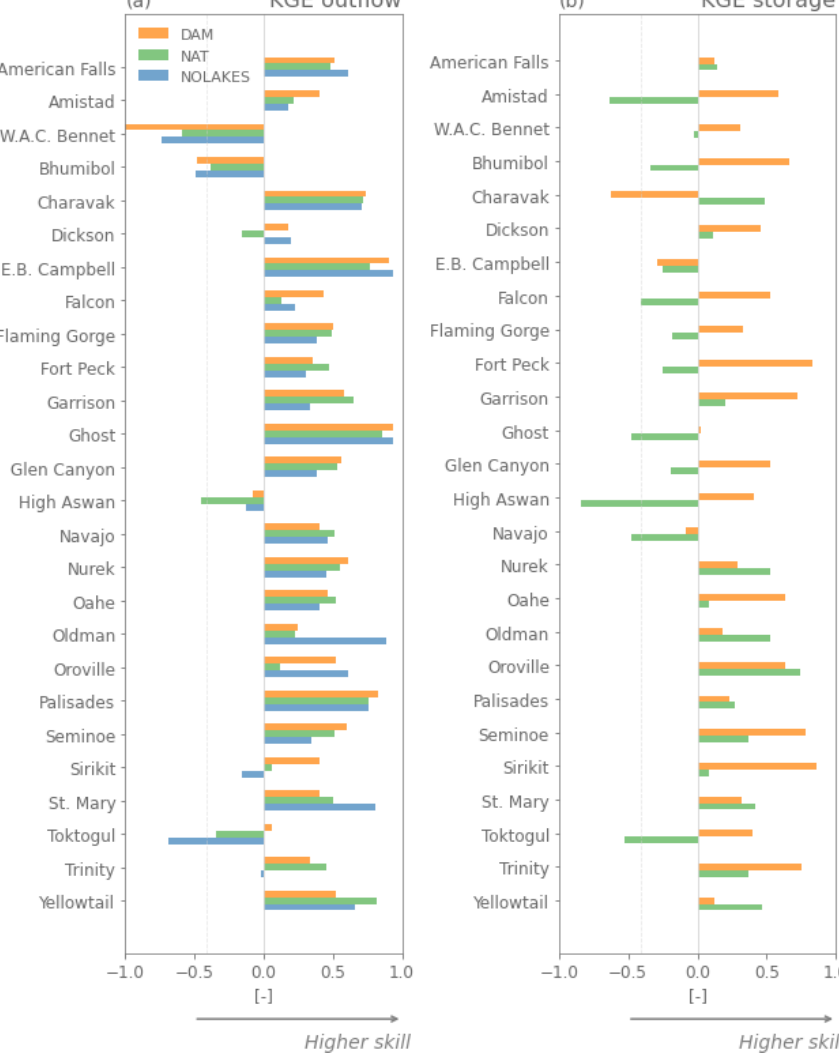
Figure 3. Evaluation using Kling–Gupta efficiency (KGE) of the Hanasaki et al. (2006, DAM) and Döll et al. (2003, NAT) parameterizations with observed inflows, and evaluation using inflow as outflow (assuming there is no lake, NOLAKE) against observed outflow (a) and observed storage (b) using observations from Yassin et al. (2019). The reservoirs are ordered from low to high capacity ratio, defined as the ratio between the mean annual inflow and storage capacity (see Table